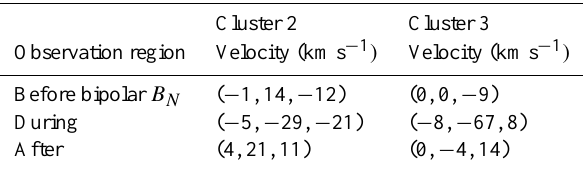
Table 2. High-time-resolution E × B drift velocity in the LMN coordinate system, calculated from parameters observed by EFW and FGM instruments on Cluster 2 and 3, during the detection of B N signature. Note that these values are calculated assuming that E · B =